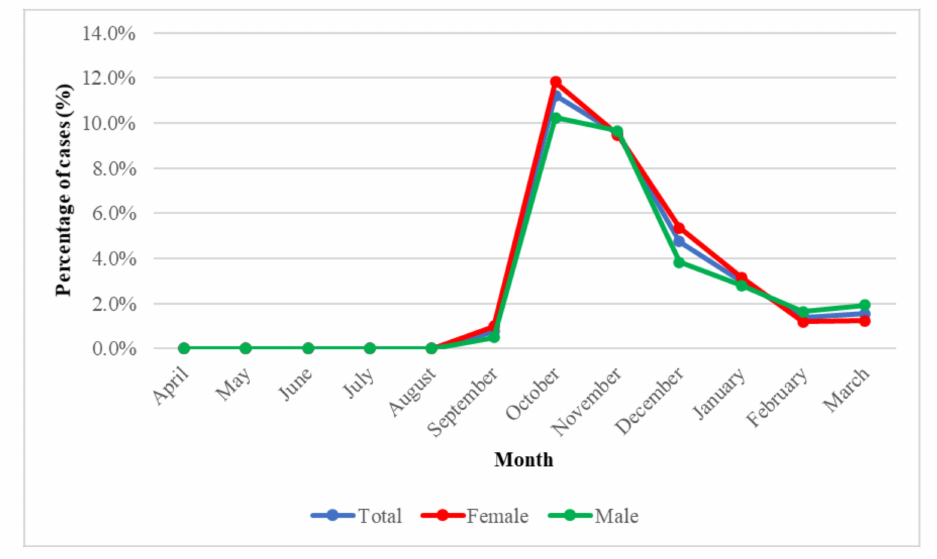
Figure 4. SARS CoV-2 infection in oncology patients (April 2020–March 2021).